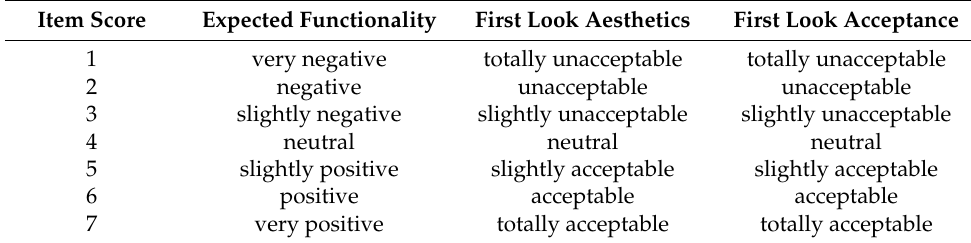
Table 1. Scoring table for the pre-test questionnaire for the factors with their semantic meaning and the corresponding value of 1–7 in the Likert scale